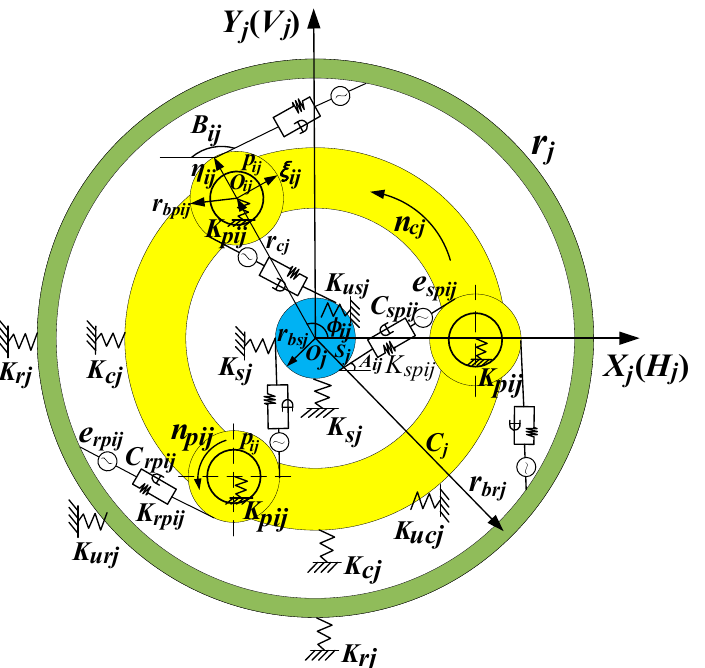
Figure 3. The dynamics model of the planetary gear system in the j th stage. In Figure 3, K sj , K rj , K pij and K cj represent the support stiffness of the sun gear, ring gear, i th planetary gear and the carrier in j th stage, respectively, and K usj , K urj , K ucj are the rotational stiffness of the sun gear, the ring gear and carrier, respectively. The meshing between the sun gear and the planetary gear is defined as external meshing, and that between the ring gear and the planetary gear is defined as internal meshing. K spij and K rpij are the stiffness of the external meshing and the internal meshing, respectively. C spij and C rpij are the damping of the external meshing and the internal meshing, respectively. e spij and e rpij are the equivalent error of the external meshing and the internal meshing, respectively. u pij , u sj and u cj are the rotational displacement of the planetary gear, the sun gear and the carrier in the j th stage, respectively. u sj = r bsj × θ sj , u pij = r bpij × θ pij , and u cj = r cj × θ cj